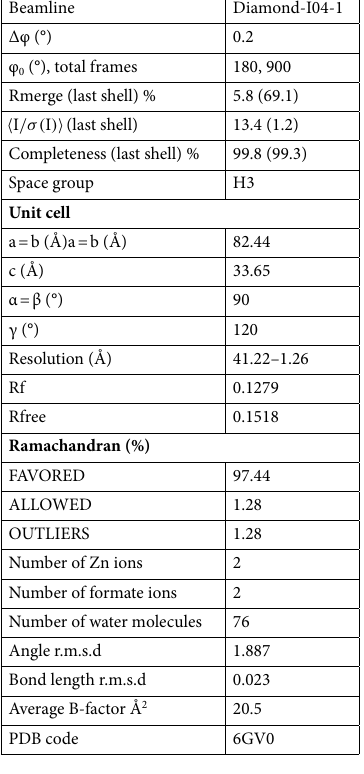
Table 1. Data collection and processing parameters of